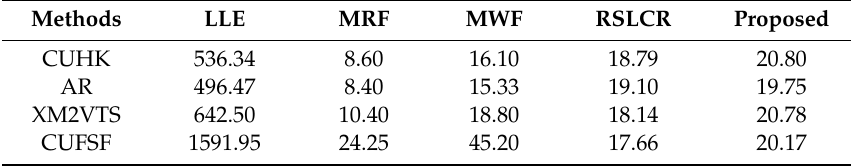
Table 1. Average running time (s) to generate one sketch by di ff erent methods.